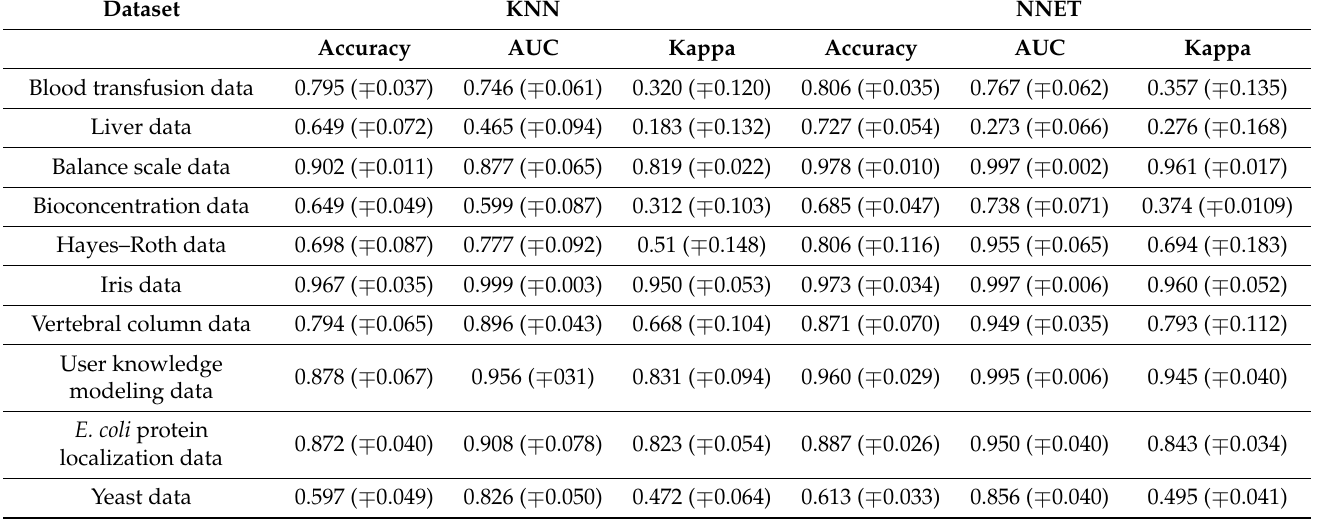
Table A2. Results of the state-of-the-art